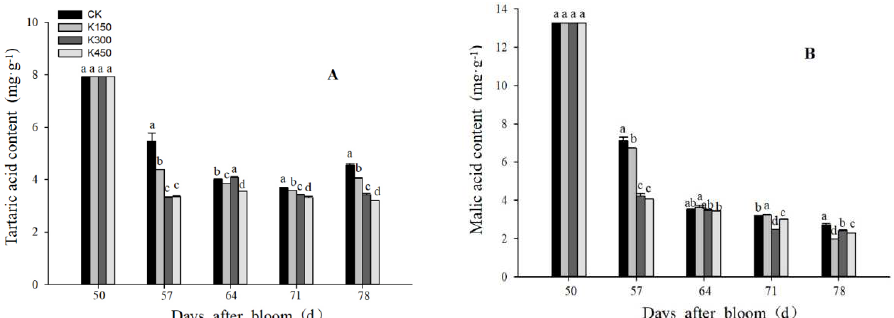
Figure 3. ( A ): Glucose content in flesh. ( B ): Fructose content in flesh. Different lowercase letters in- dicate significant differences among the treatments (Duncan’s Multiple Range Test, p < 0.05).